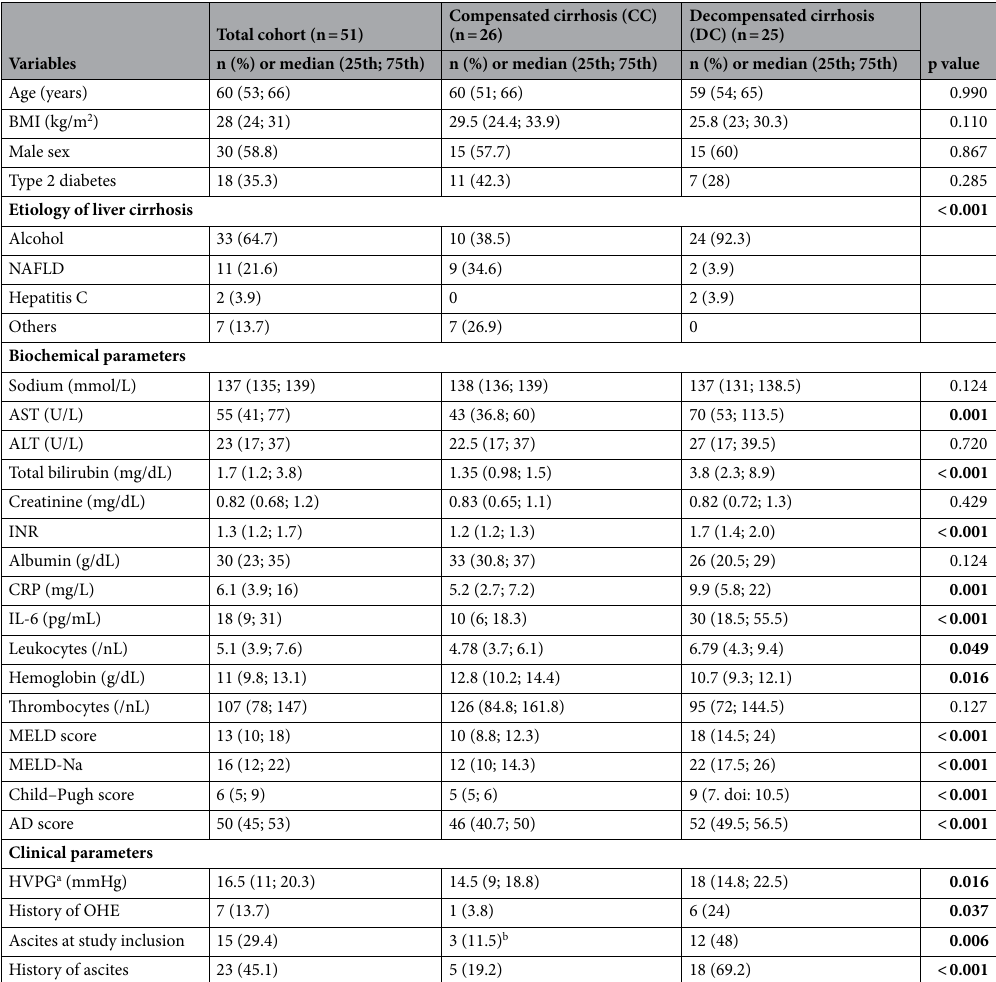
Table 1. Clinical characteristics, demographic data, and differences between compensated and decompensated liver cirrhosis. Data are expressed as numbers, medians, percentages (%) or interquartile ranges (IQR 25th; 75th). AD acute decompensation, ALT alanine-aminotransaminase, AST aspartate-aminotransaminase, BMI body mass index, CRP C-reactive protein, OHE overt hepatic encephalopathy, INR international normalized ratio, HVPG hepatic venous pressure gradient, MELD model for end-stage liver disease, NAFLD nonalcoholic fatty liver disease. p values refer to the comparison between compensated (CC) and decompensated (DC) liver cirrhosis. Boldface indicates statistical significance. A p value < 0.05 was considered significant. a Measured in 46 patients. b Only a small volume of ascites was detected on abdominal ultrasound and not accessible for